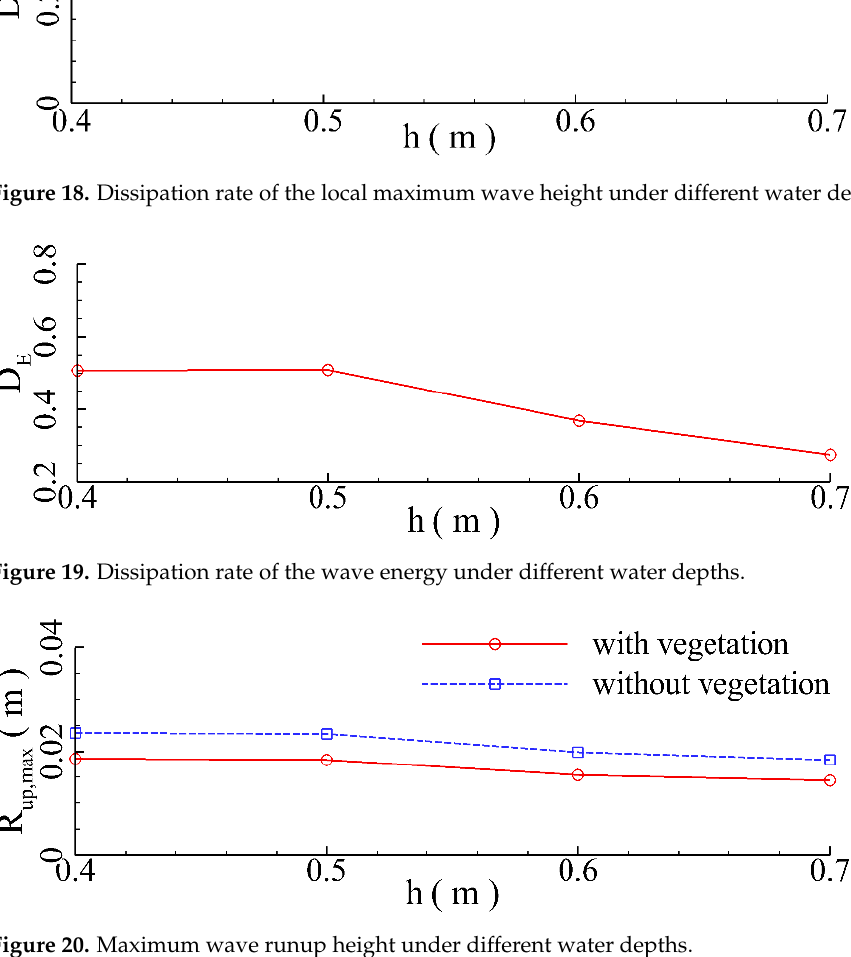
Figure 20. Maximum wave runup height under different water depths.